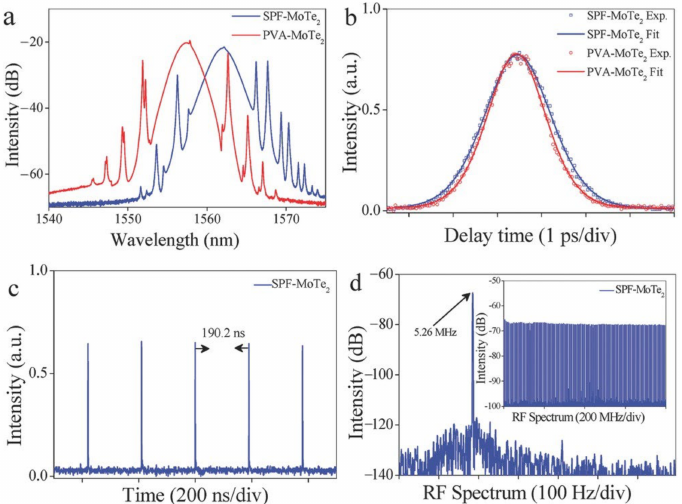
Figure 4. Results of the WTe 2 mode-locked fiber lasers. ( a ) Spectrum, ( b ) autocorrelation trace, ( c ) pulse train and ( d ) RF spectrum. Reprinted with permission from